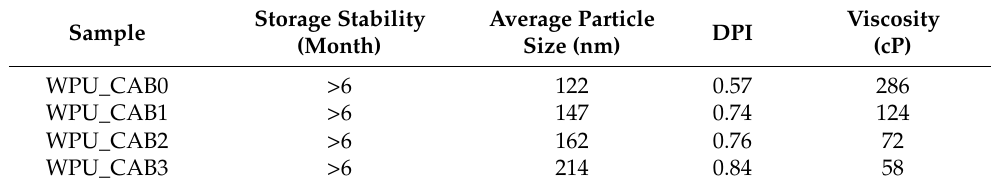
Table 2. Characteristics of WPU dispersions with different CAB contents.